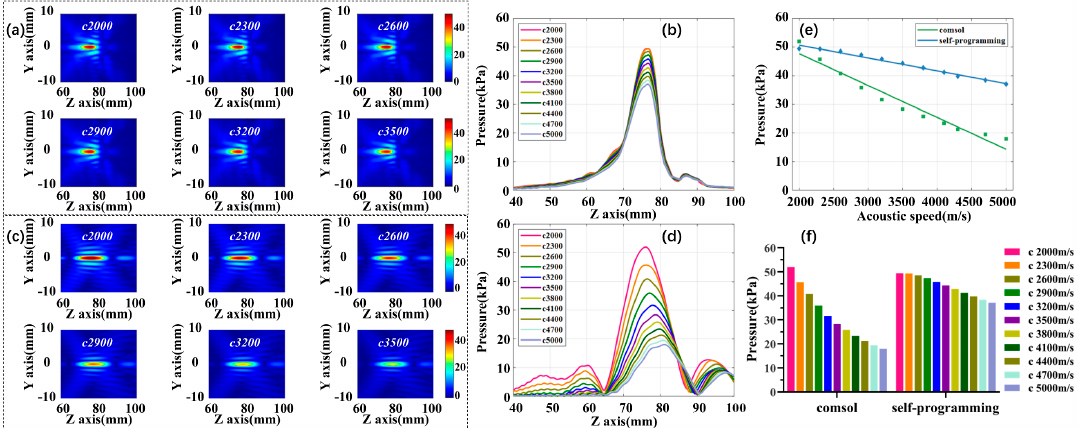
Figure 9. The effect of acoustic speed varied on focus acoustic pressure. ( a ) Self-programming focus acoustic pressure field; ( b ) self-programming acoustic axis acoustic pressure curve; ( c ) COMSOL focus acoustic pressure field; ( d ) COMSOL acoustic axis acoustic pressure curve; ( e ) focus acoustic pressure variation fitting curves for both simulations; ( f ) histogram of focus acoustic pressure variation for both simulations.